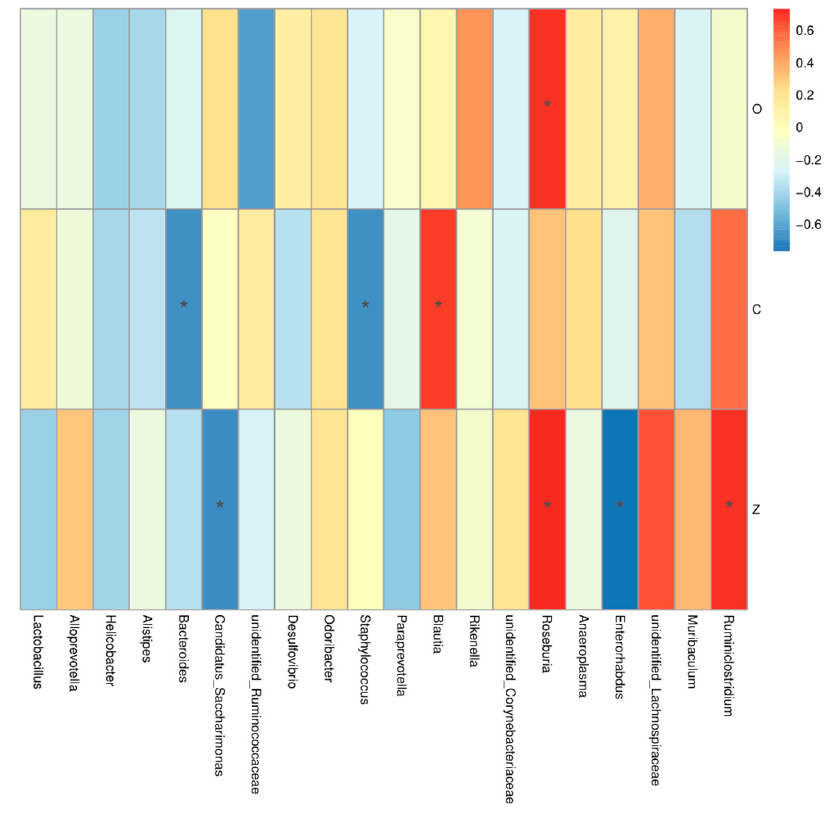
Figure 12. Heatmap of Spearman correlation analysis between the top 20 abundant genera of the intestinal microbiome and TJ proteins of mice. The Spearman correlation coefficient r ranges from − 0.5 to 0.5; r < 0 is negative correlation; r > 0 is positive correlation; *: p < 0.05. Note: O means occludin; C means claudin-1; Z means ZO-1.